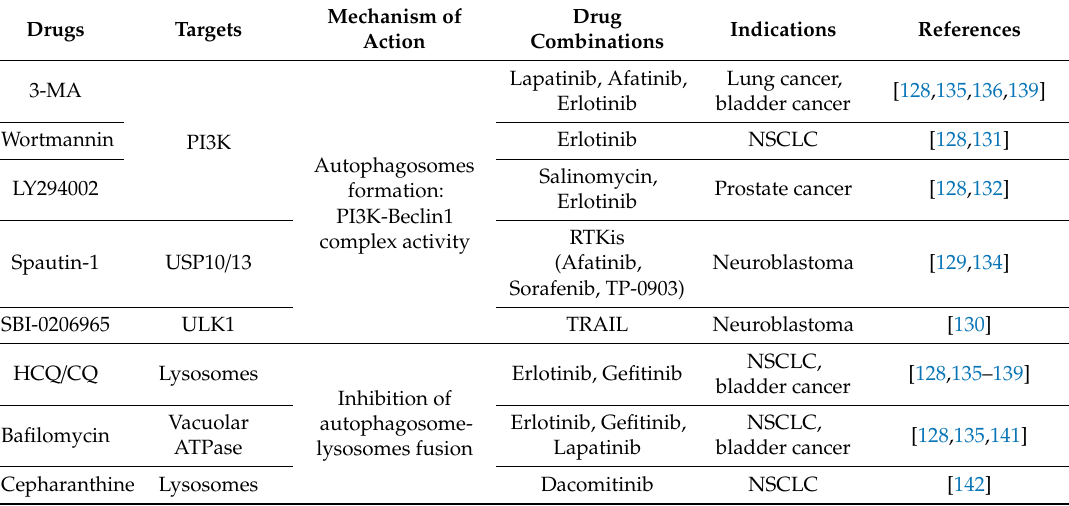
Table 2. Summary of anti-autophagic